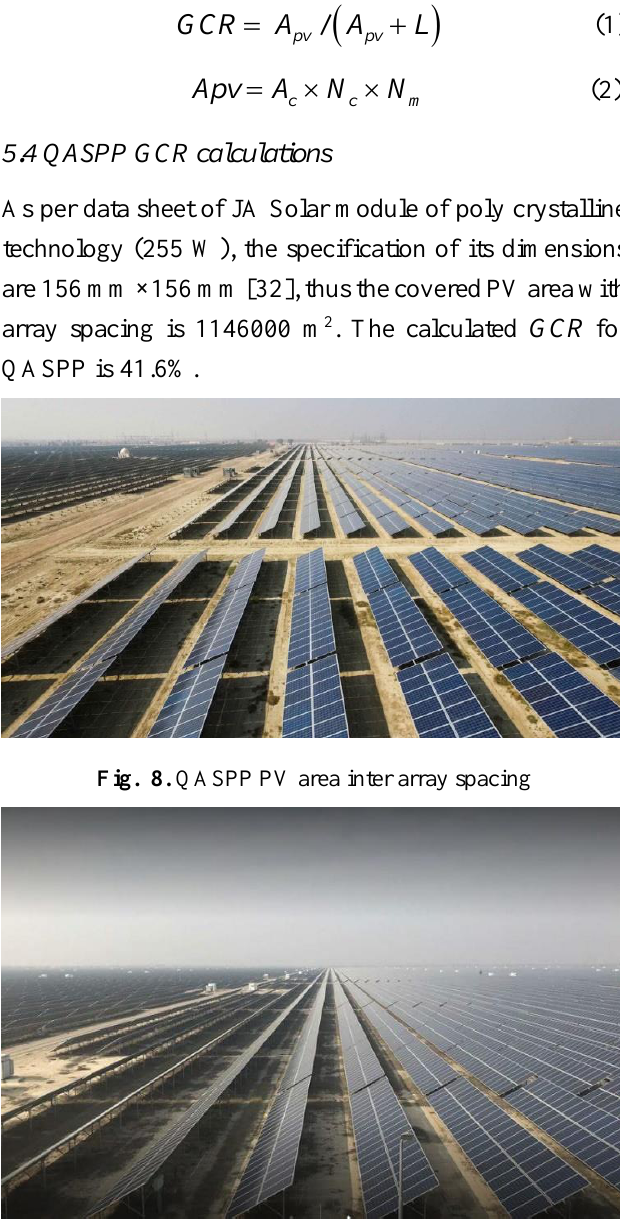
Fig. 9. Crest energy PV area inter array